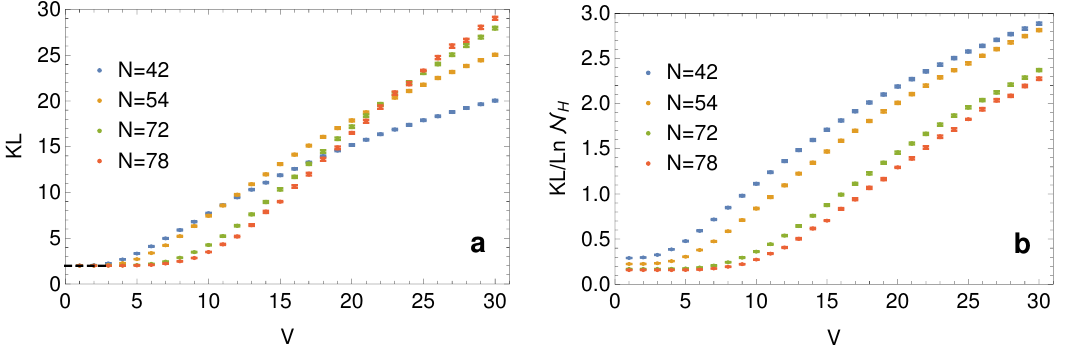
Figure 3: Panel a . Kullback-Leibler divergence KL of eigenstates adjacent in the many-body spectrum as a function of the disorder strength V and for different sam- ples. Panel b . Kullback-Leibler divergence rescaled by the system